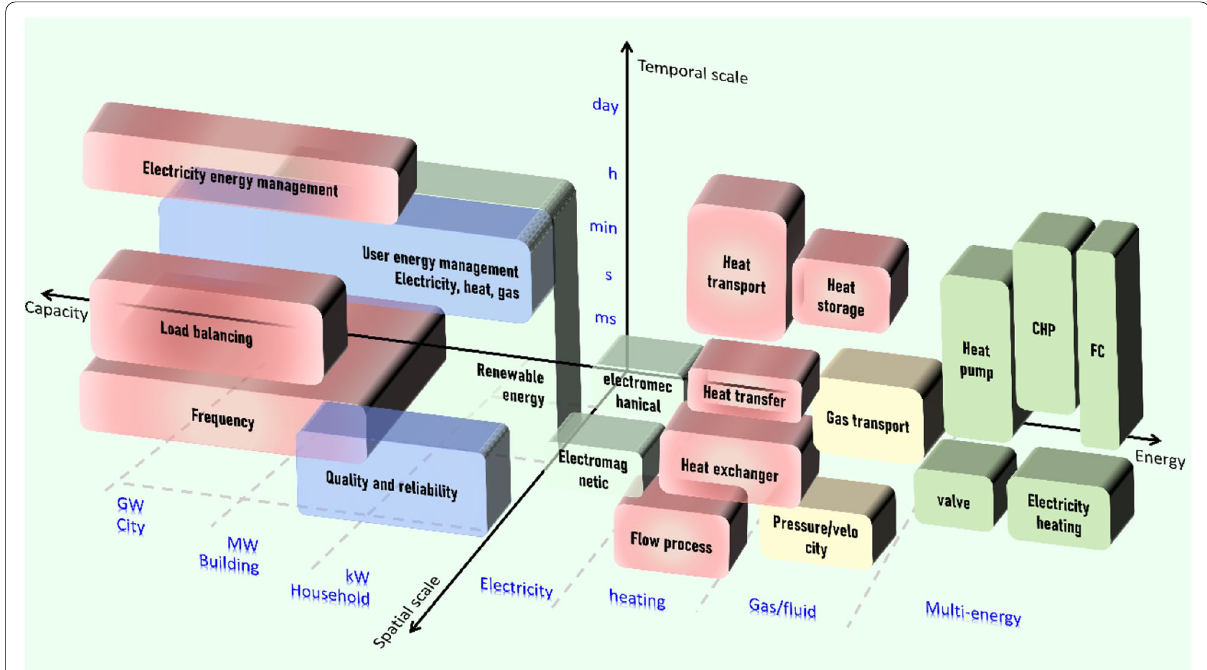
Fig. 6 Typical characteristics of the distributed energy